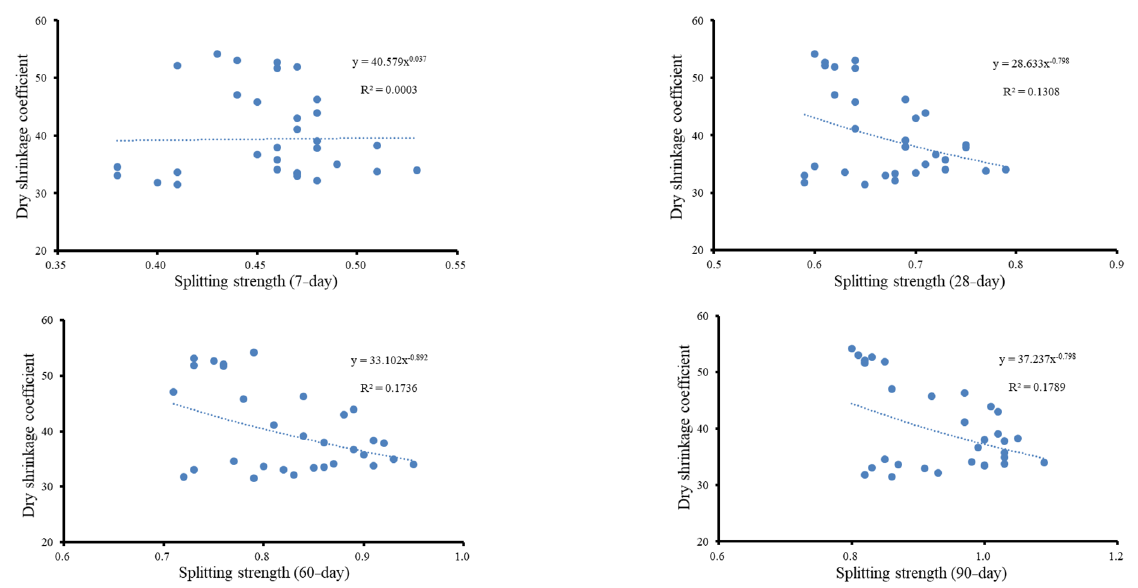
Figure 9. Relationships between spliing strengths and dry shrinkage coefficients.